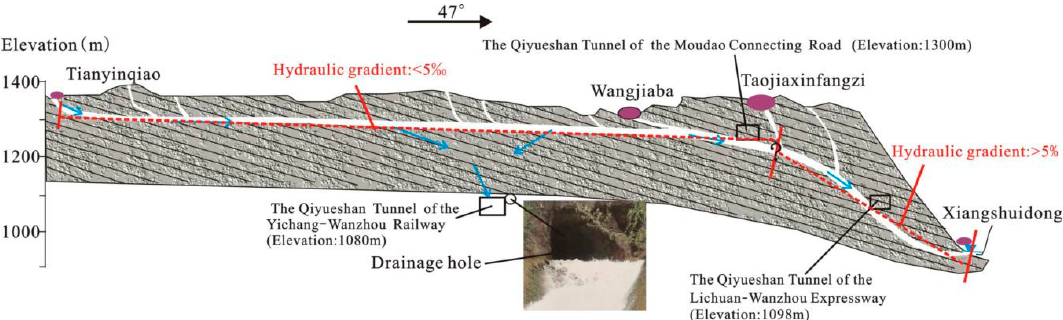
Figure 14. Relative position model of underground river and tunnels (Figure 7a, 1-2 Section). Image recreated from [29].